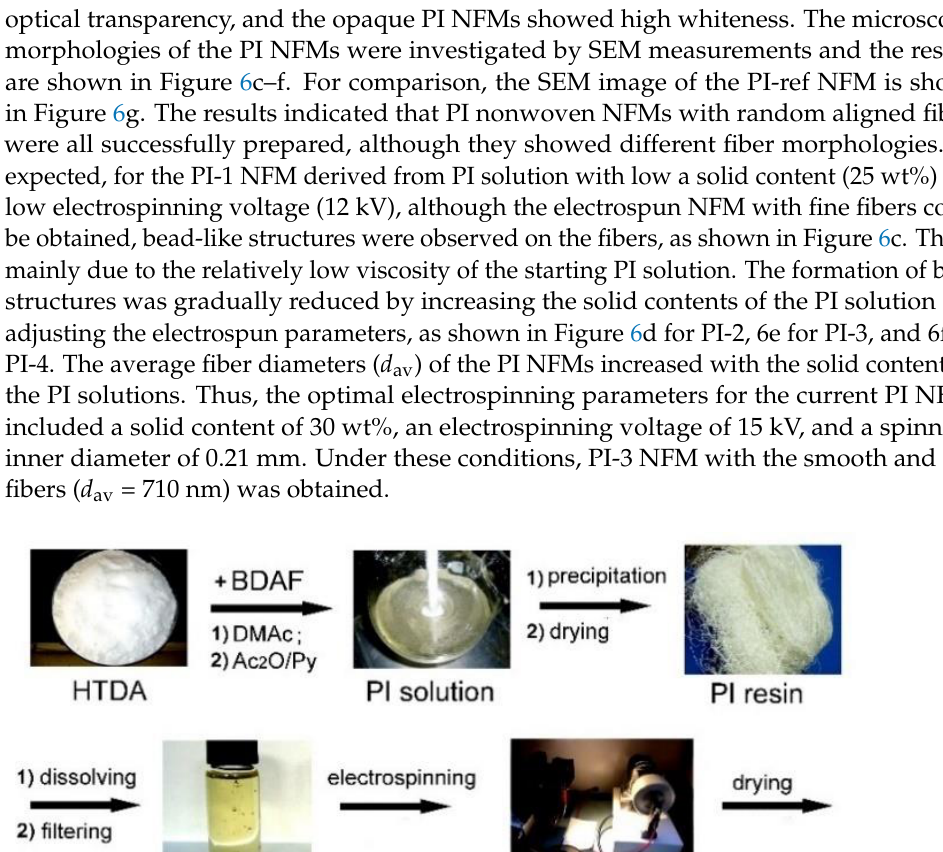
Figure 6. Macroscopic and microscopic morphology of PI samples. ( a ) Appearance of PI film; ( b ) appearance of PI membranes; ( c – f ) SEM images of PI-1, PI-2, PI-3, and PI-4 membranes, respectively; ( g ) SEM image of PI-ref NFM.